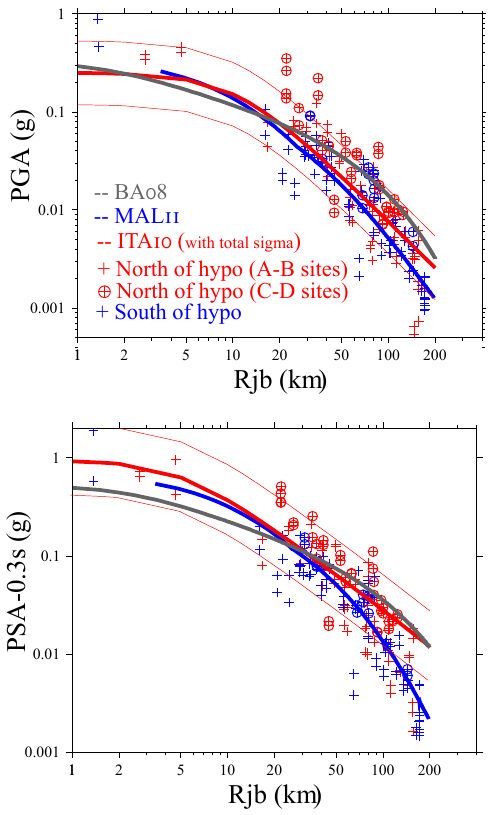
Figure 2. Two horizontal components of PGA, PGV and PSA at 0.3 and 1 s compared with the ground- motion empirical predictive model of BA08, ITA10 and MAL11 as a function Rjb distances between 0 and 200 km.